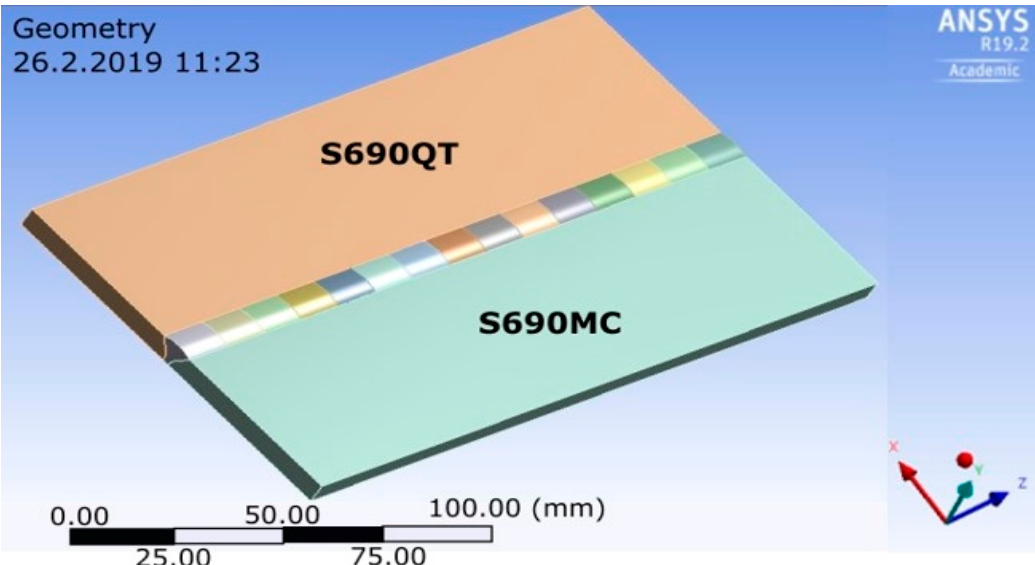
Figure 1. The geometry of the sample.